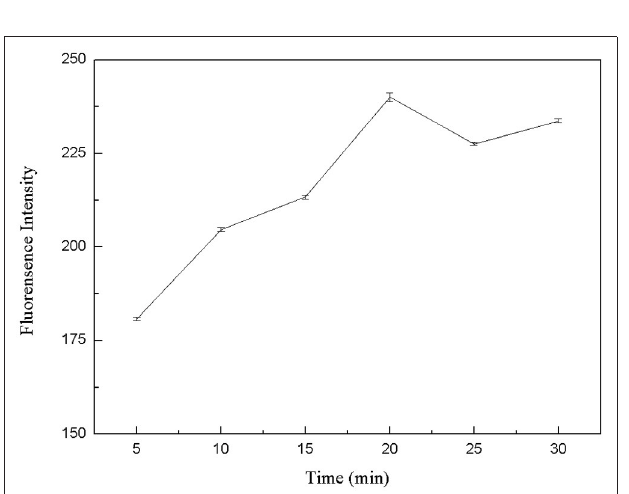
FIGURE 9 | Comparison of the fluorescence recovery ( F–F 0 ) of this assay used for different antibiotics, including streptomycin (a), chloramphenicol (b), ciprofloxacin (c), tetracycline (d), oxytetracycline (e) and kanamycin (f). The concentration of FDNA was 0.05 µ M, QDNA2 was 0.1 µ M, and the antibiotics were